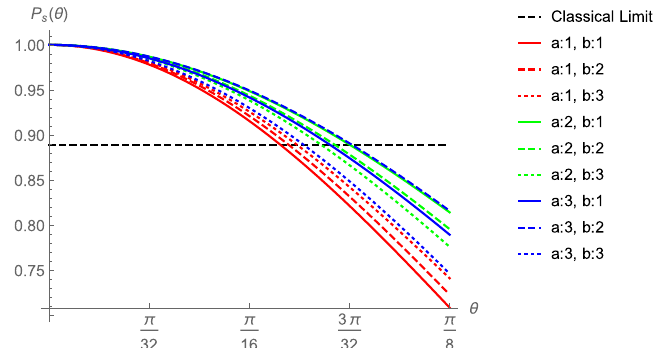
a , b referee can give Alice and { } CP (π) but ≡ 1 and b 1 , respectively) are more complex = = θ) . Hence, success probability of players − 1 b = =